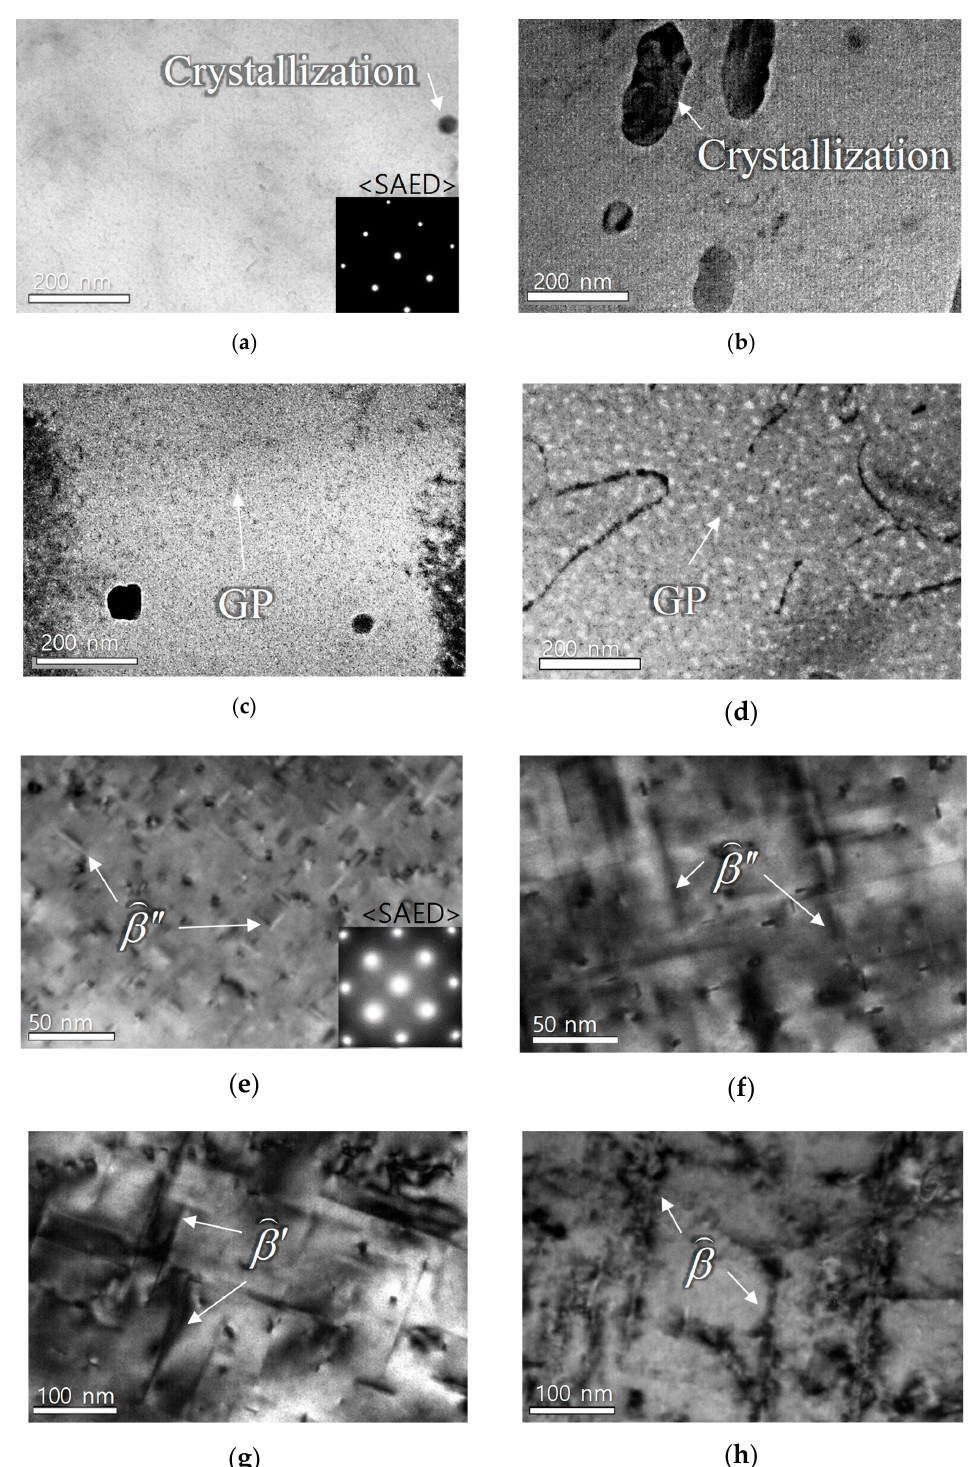
Figure 10. The bright field images taken by the transmission electron microscopy; ( a ) 0 min; ( b ) 20 min; ( c ) 40 min; ( d ) 1 h; ( e ) 2 h; ( f ) 10 h; ( g ) 100 h; ( h ) 1000 h; the selected area electron di ff raction patterns are shown in ( a ) and ( e